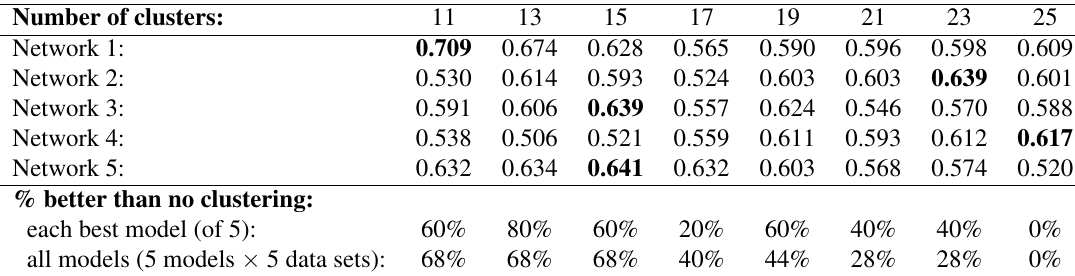
Table 2: Size 25 network AUROC scores. For each of 5 simulated data sets, the table shows the AU- ROC from the highest-likelihood inferred network (of 5) from each of a range of cluster numbers. The best score for each network is shown in bold. The bottom two rows give (1) the percentage of data sets for which the best model for the particular number of clusters out-performed the best no-clustering ( i.e. 25 cluster) model, and (2) the percentage of the all models fit for the particular number of clusters that out-performed the best no-clustering